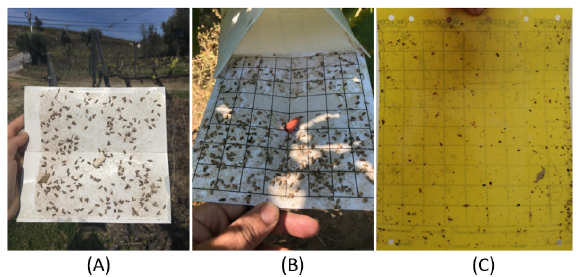
Figure 7. Examples of removal of inadequate images due to: ( A ) camera distance; ( B ) camera angle and illumination; and ( C ) low image